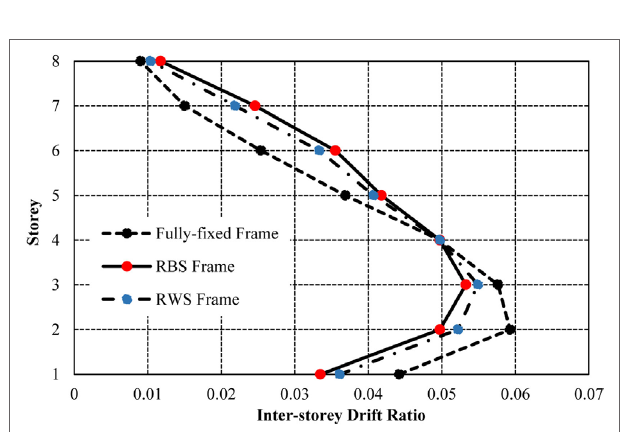
Figure 21 | Inter-storey drifts in 8-storey frame.